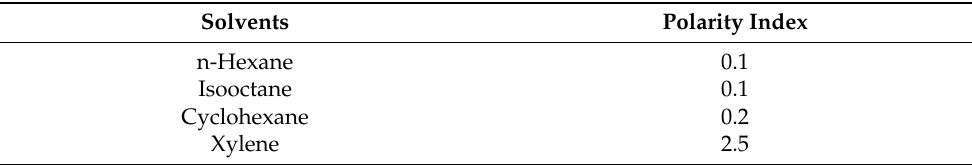
Table 5. Polarity of solvents.